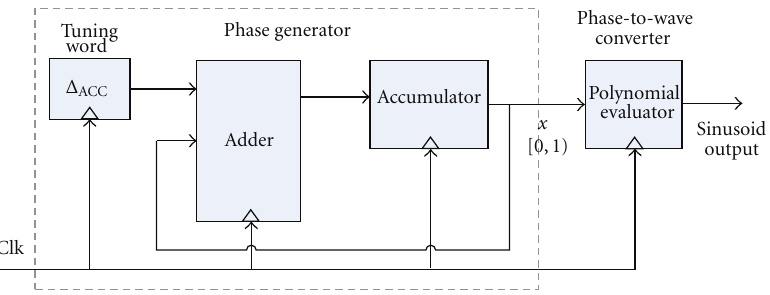
Figure 3: Architecture for the complex sinusoid generation